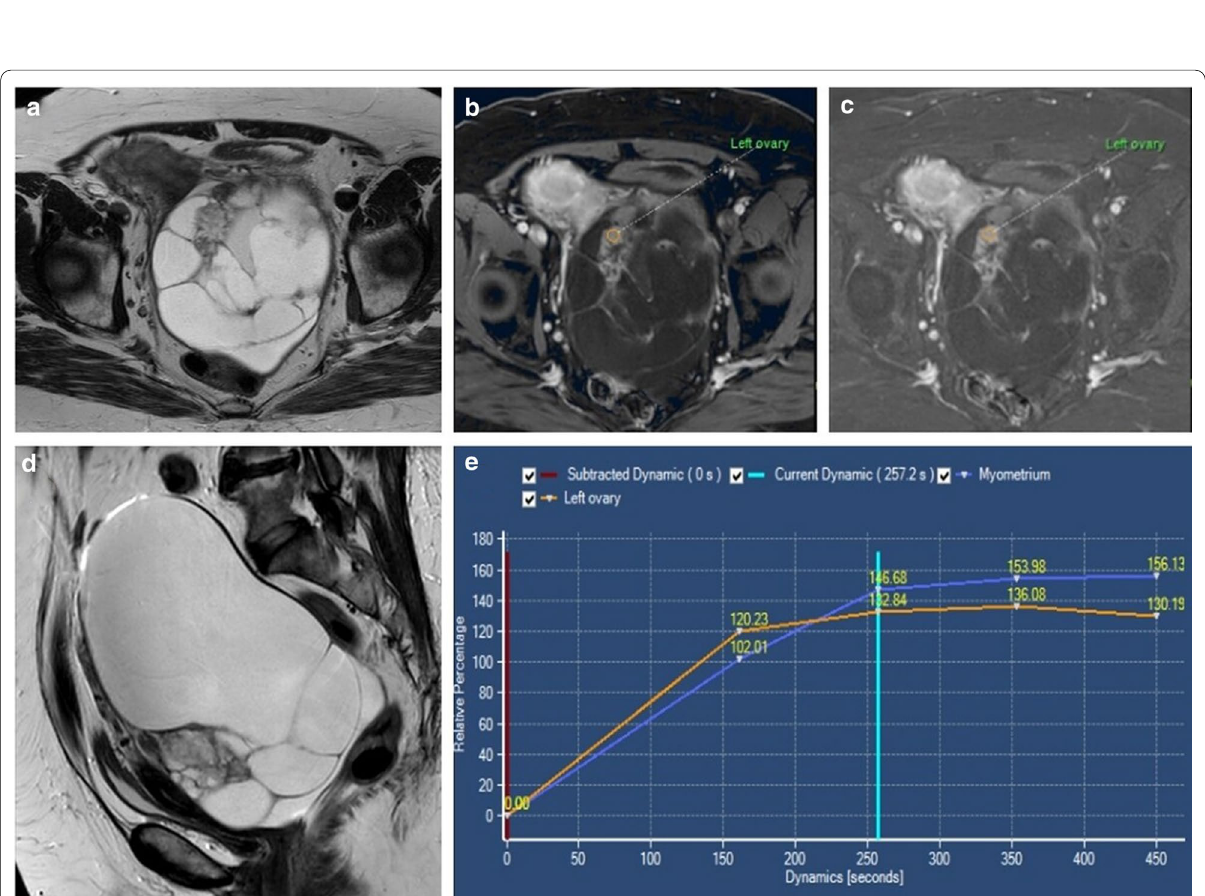
Fig. 11 LGSC of the left ovary in a 61-year-old female. Axial and sagittal T2-weighted MR images ( a , d ), axial T1-weighted MR image with fat saturation, after intravenous gadolinium administration ( b ) and post-contrast subtraction ( c ) demonstrate a large multicystic left ovary tumour, with some thick septations and solid parietal nodules. The larger nodule displays a type 3 contrast enhancement curve ( e ), which is commonly found in malignant epithelial ovarian tumours. It shows an initial contrast uptake higher than the myometrial uptake, followed by